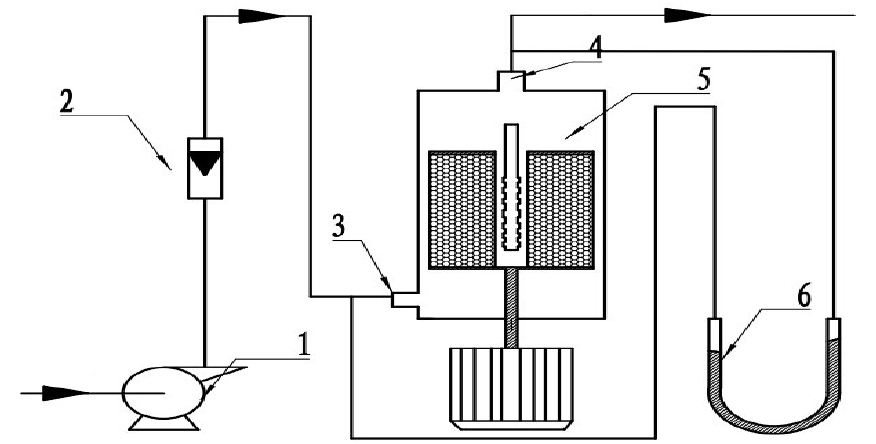
Figure 2. Schematic diagram of the experimental setup: (1) roots blower; (2) rotameter; (3) gas inlet; (4) gas outlet; (5) cross-flow RPB; (6) manometer. (4) gas outlet; (5) cross-flow RPB; (6)